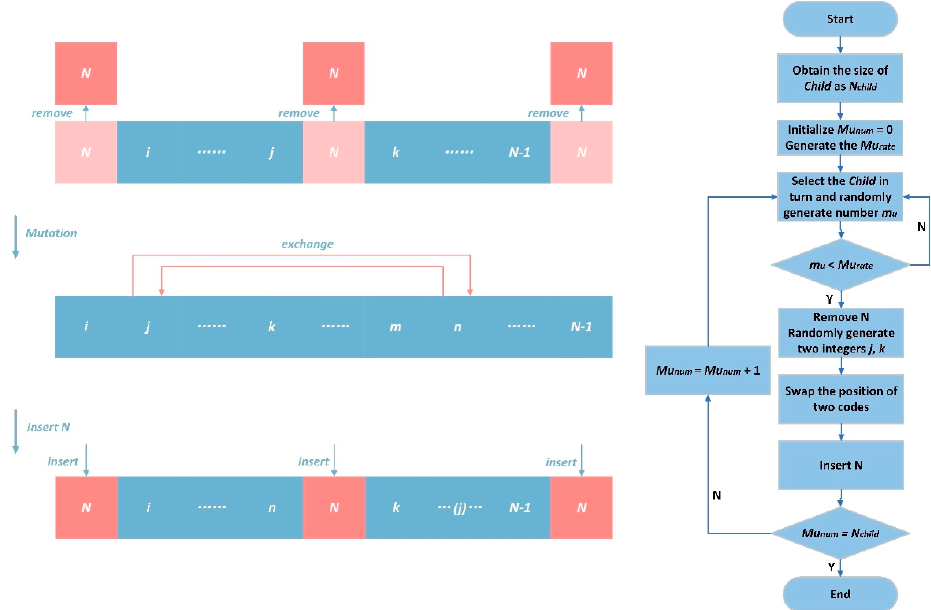
Figure 8. The schematics and the flowchart of the mutation operator. After selecting the water landing site, the population and the parameters of the population were initialized randomly. Then, within the evolution times, the population evolved by using the self-optimization based on LNS, selection operator, crossover operator, and mutation operator. The flowchart of the GA* is show in Figure 9.